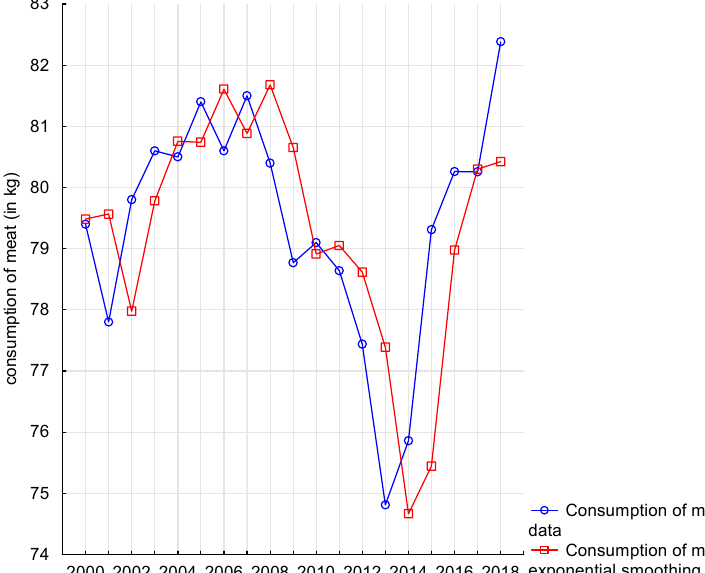
Figure 11. Total meat consumption between 2000 and 2018 [27].